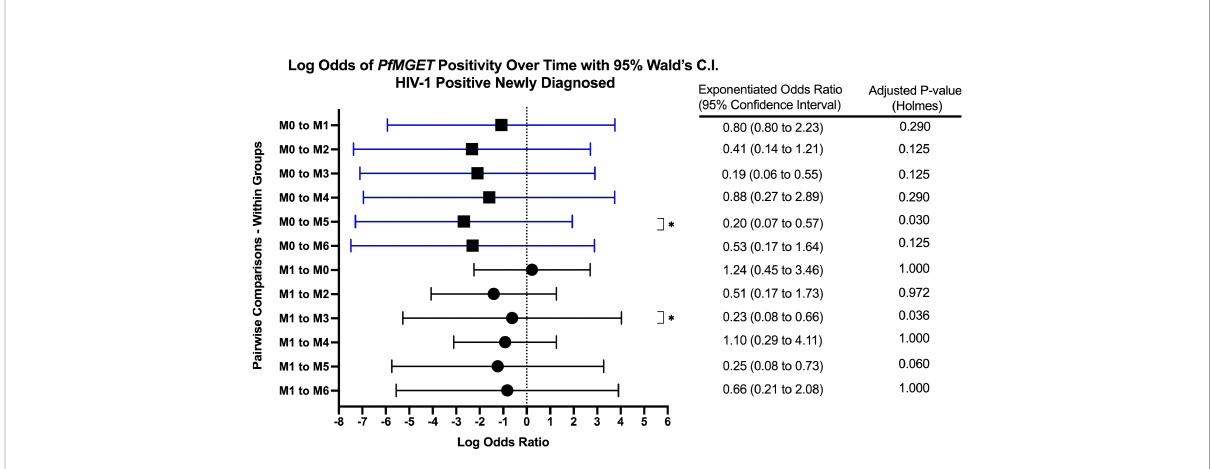
FIGURE 7 Forest Plot of the Log Odds of PfMGET Positivity in HIV-1 Positive Newly Diagnosed Volunteers. The log odds and accompanying exponentiated adjusted odds ratio of being positive for at least one gametocyte speci fi c transcript within the HIV-1 positive newly diagnosed study group between month 0 (M0) and between month 1 (M1). P-values were adjusted using the Holm ’ s method for multiple comparisons. Blue con fi dence interval lines are comparisons with month 0 and black con fi dence interval lines are comparisons with month 1.